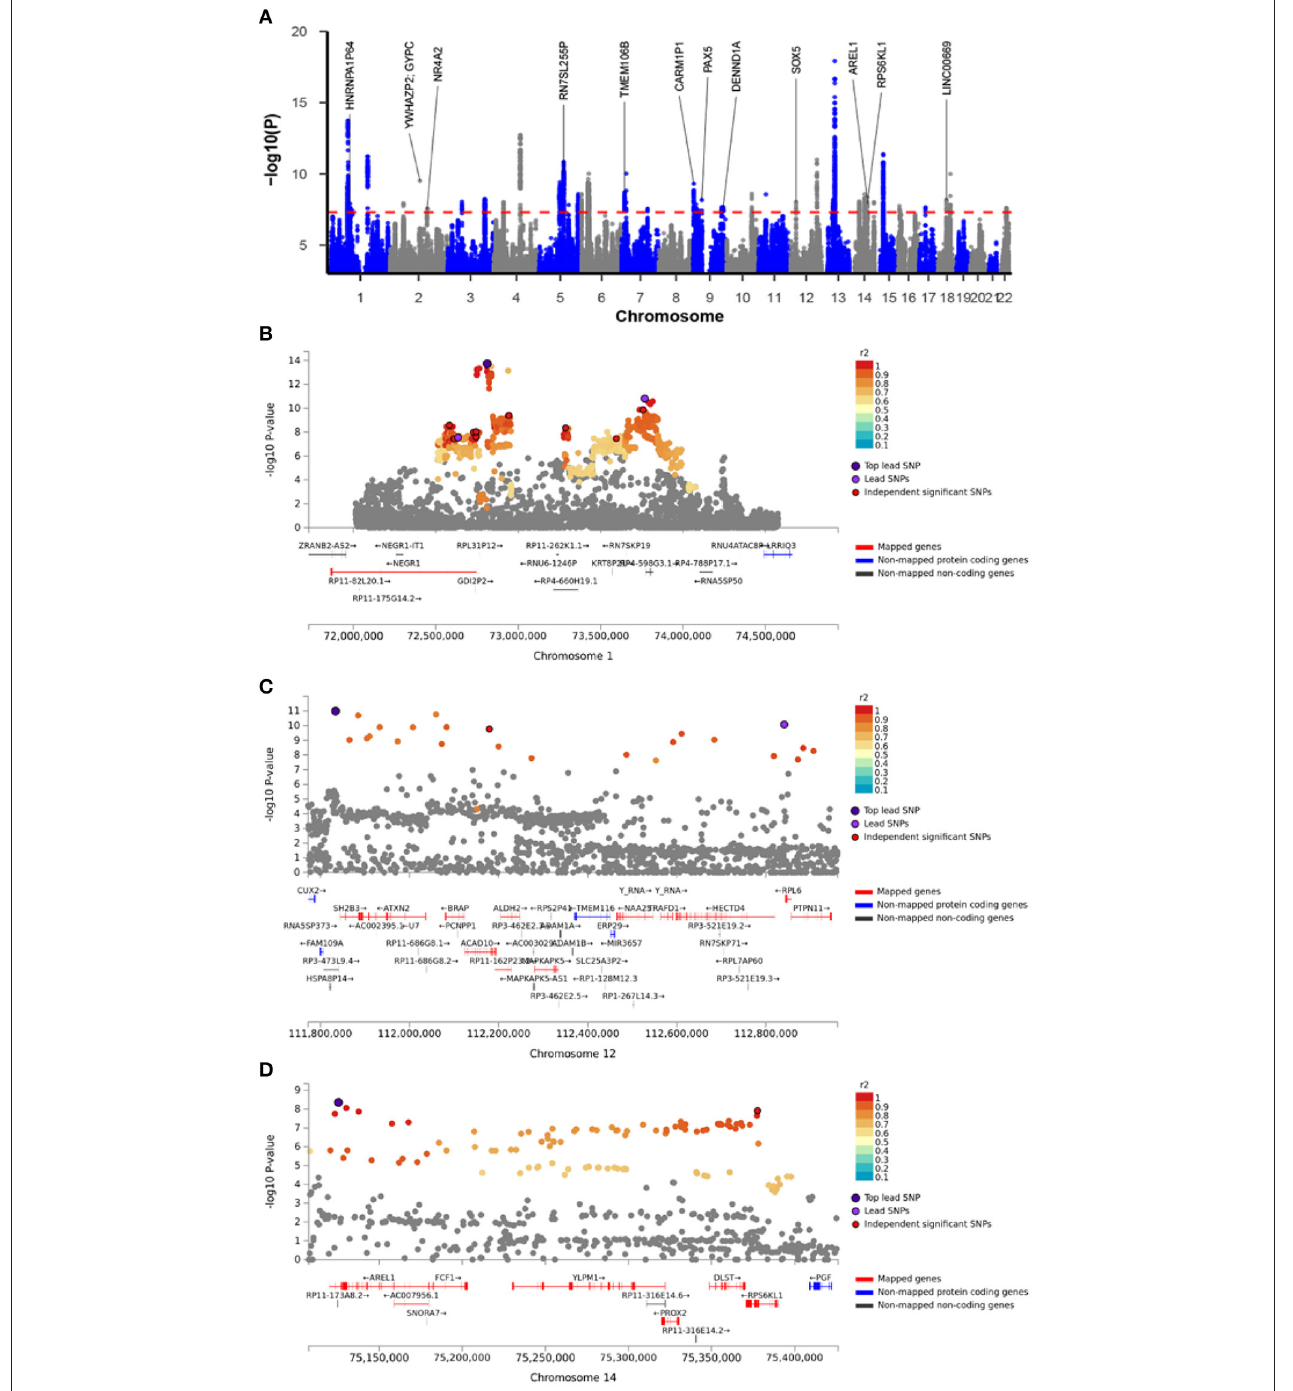
FIGURE 2 | Meta-analysis of major depressive disorder with stroke. (A) Manhattan plot of the meta-analysis. The x-axis is the chromosomal position of SNPs and the y-axis is the significance of the SNPs (-log 10 P). Genes implicated by independent significant SNPs were annotated. (B–D) The four highlighted genomic loci. Each SNP is color-coded based on the highest r 2 to one of the independent significant SNPs if that is greater or equal to the r 2 threshold of 0.6. Other SNPs (below the r 2 of 0.6) are colored in gray.